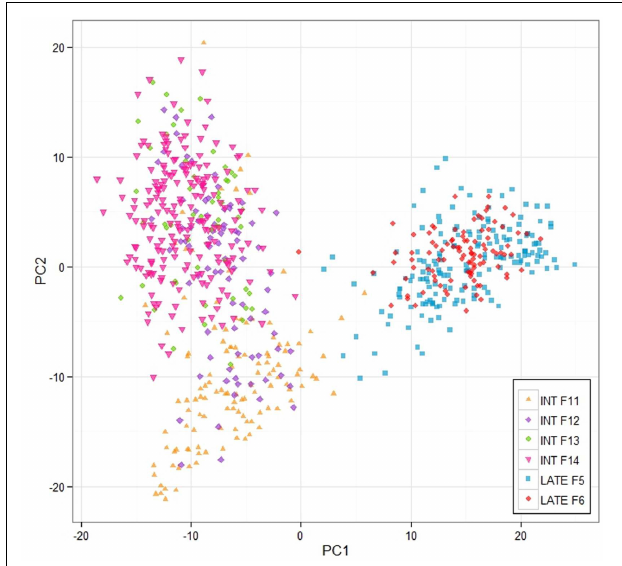
FIGURE 2 | Principle components analysis of the breeding populations. The analysis and the plot was based on the 3 K Infinium Array SNP data, and the analysis was implemented in